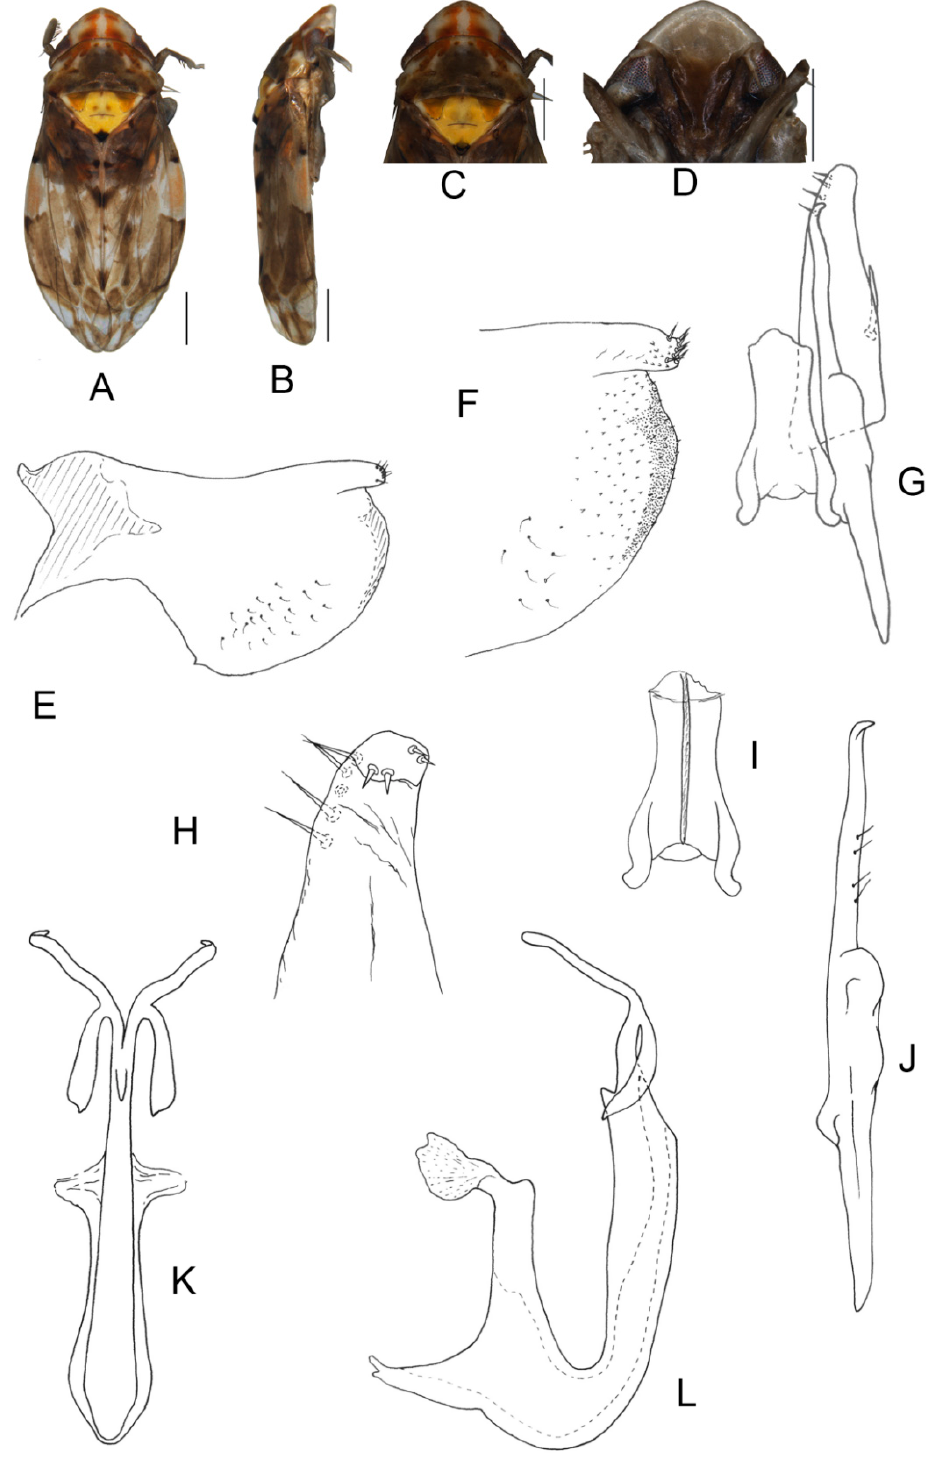
Figure 16. Eurhadina ( Singhardina ) flaviscutella sp. nov. : ( A ) habitus, dorsal view; ( B ) habitus, lateral view; ( C ) head and thorax, dorsal view; ( D ) face; ( E ) male pygofer side, lateral view; ( F ) hind part of pygofer, lateral view; ( G ) subgenital plate, connective and paramere, dorsal view; ( H ) apex of subgenital plate, dorsal view; ( I ) connective, dorsal view; ( J ) paramere, dorsal view; ( K ) aedeagus, posterior view; and ( L ) aedeagus, lateral view. Scale bars: 0.5 mm. Eurhadina ( Singhardina ) fusca Cai et Kuoh, 1993 Eurhadina ( Singhardina ) fusca Cai et Kuoh, 1993: 222, Figure 1 [9]. Distribution. China (Yunnan).